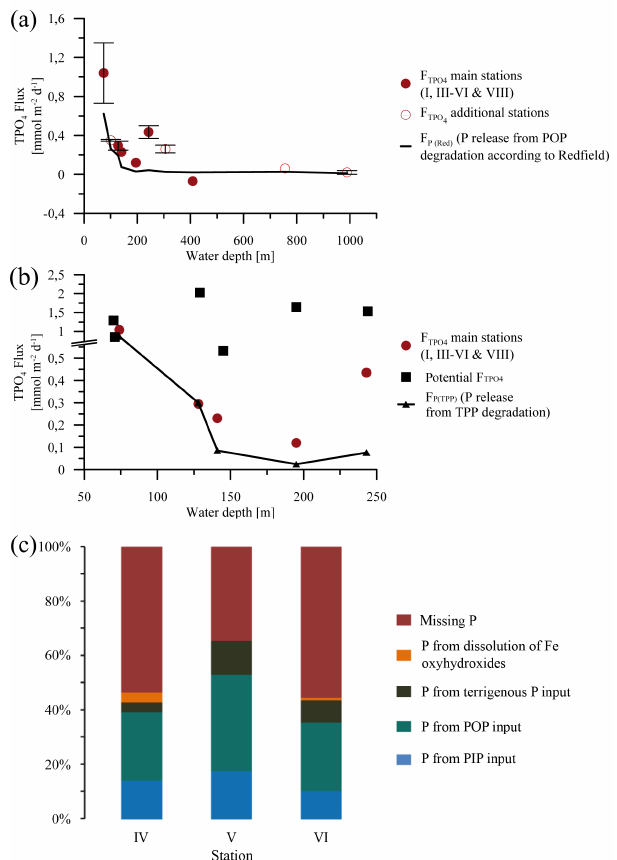
Figure 4. (a) Measured benthic TPO 4 fluxes (mmolm − 2 d − 1 ) at 12 ◦ S. The black line shows the theoretical TPO 4 flux generated from organic matter degradation with a Redfield POC / POP ratio of 106. (b) Potential TPO 4 fluxes (mmolm − 2 d − 1 ) calculated from porewater profiles compared to the measured benthic TPO 4 fluxes (mmolm − 2 d − 1 ) at stations I to VIII (74 to 407m). The black line with triangles depicts the TPO 4 flux that could be generated during degradation of total particulate phosphorus. (c) P percentages of the different P sources and the missing P that is needed to maintain the measured TPO 4 release rates and P burial fluxes for stations IV, V, and VI (141, 195, and 244m) of transect section II. The missing P is assumed to be supplied by sulfide-oxidizing Marithioploca -related bacteria (see